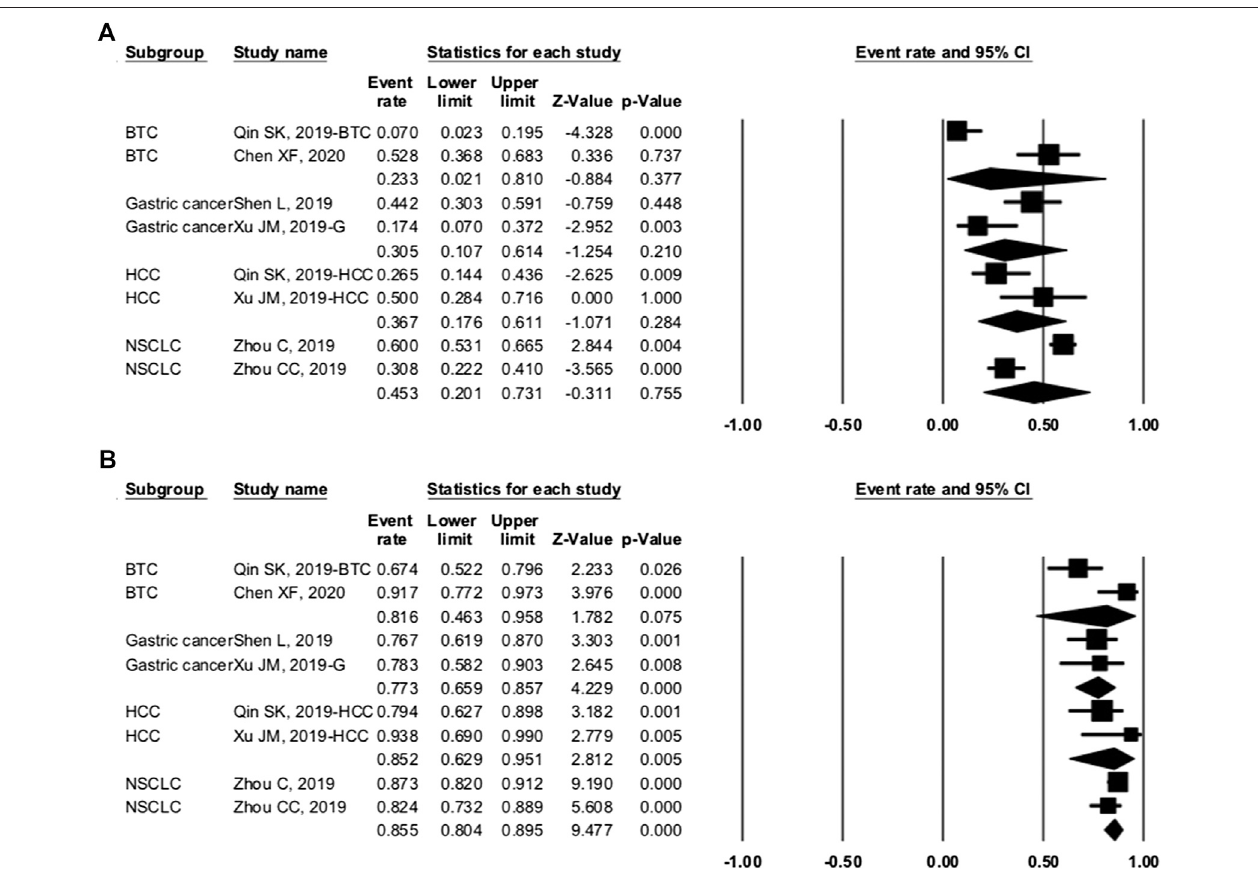
FIGURE 7 | Subgroup analysis of cancer types. (A) overall response rate and (B) disease control rate of different cancers.